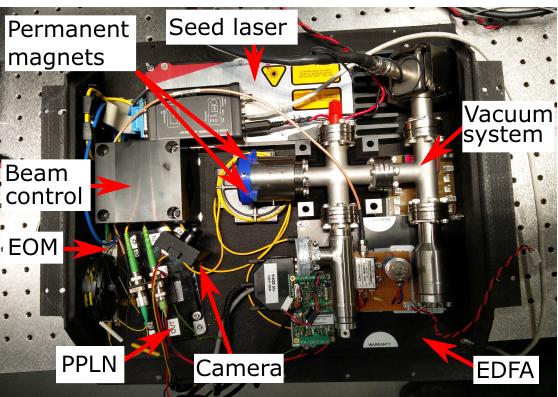
Figure 3. Photo showing the laser system and vacuum system integrated into the carbon fibre